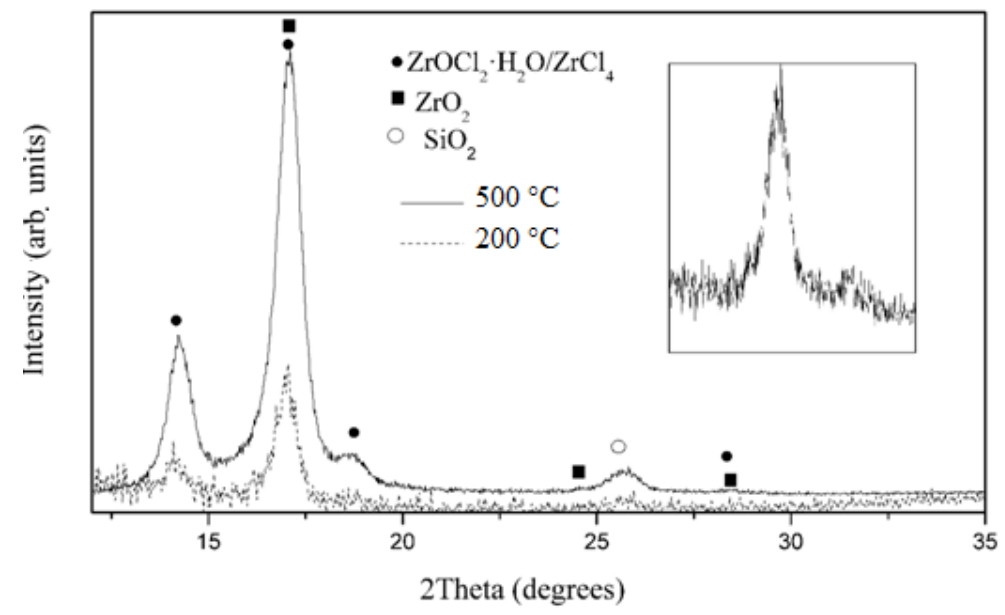
Figure 4. X-ray diffraction (XRD) patterns of the SiO 2 ZrO 2 films thermally treated at 500 ◦ C and 200 ◦